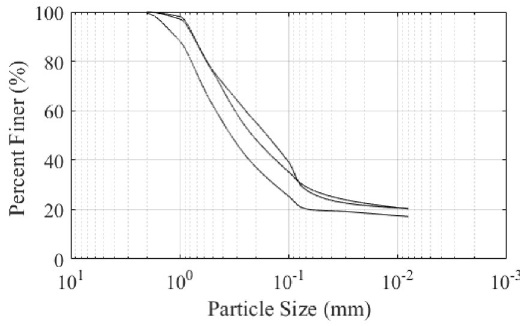
Figure 13. Particle size distribution of the special soil.